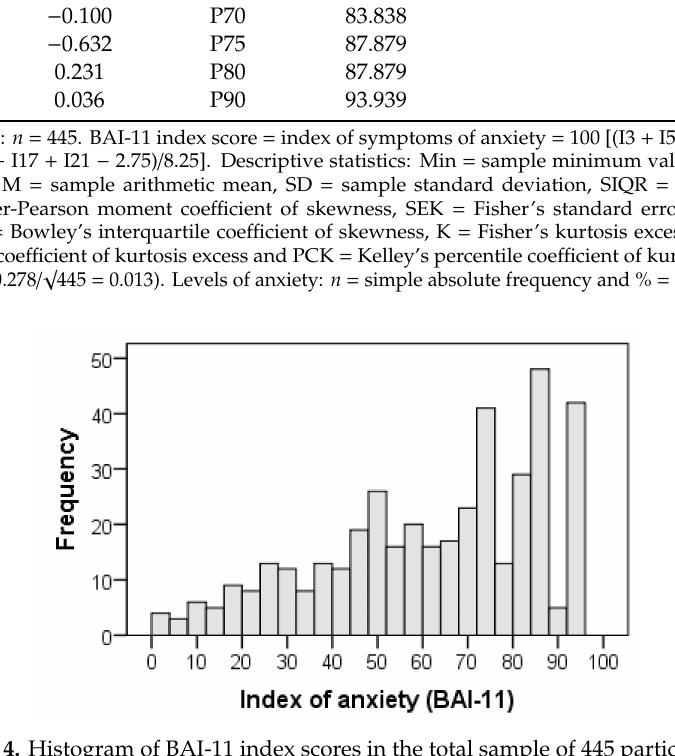
Figure 4. Histogram of BAI-11 index scores in the total sample of 445